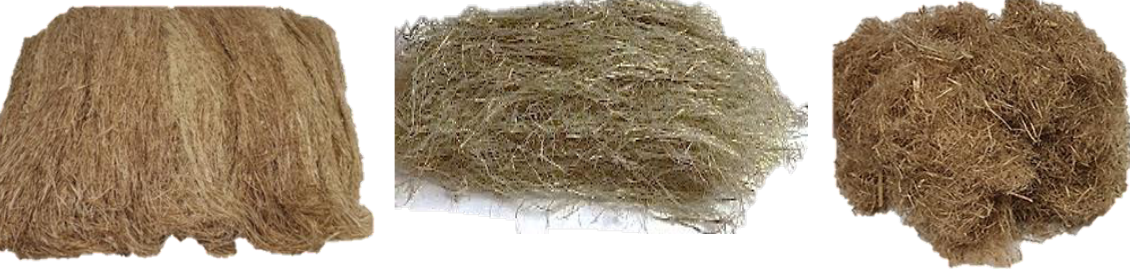
Figure 2. Sorted fiber (SF), raw fiber (RF), chopped fiber (CF).